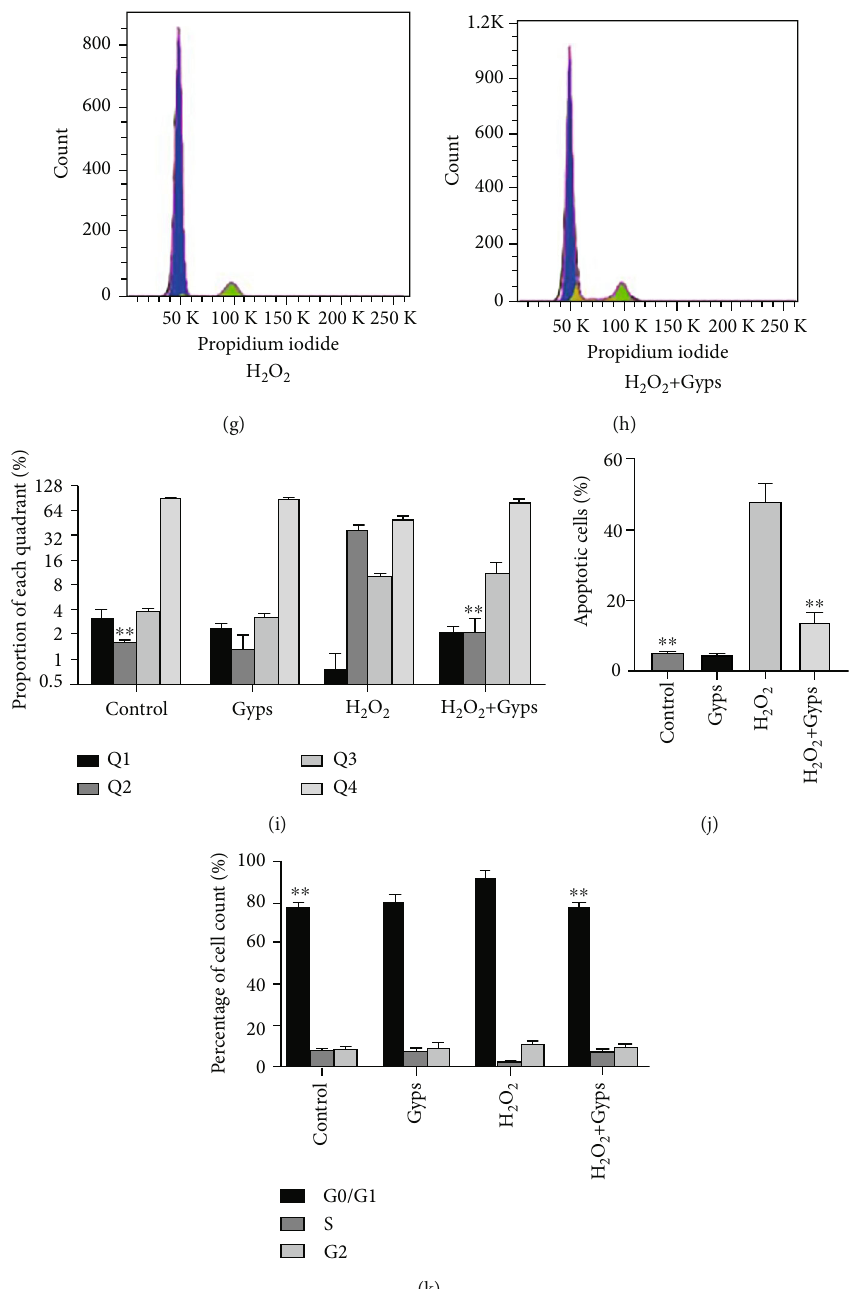
Figure 9: The e ff ect of gypenosides on apoptosis and cycle induced by H on H O -induced apoptosis and cell cycle. (a – d) Flow cytometry detection. (e – h) Flow cytometry. (i) Results of cell ratio in 4 regions. (j) 2 2 Results of cell apoptosis rate in each group. (k) Results of cell cycle in each group. Three samples from each of the three GO donors were taken for the experiment. All detections are repeated 3 times, with 3 replicate wells each time ( ∗ as P < 0 : 05 and ∗∗ as P < 0 : 01 ; P < 0 : 05 means the di ff erence is statistically signi fi cant, and P value is analyzed by one-way